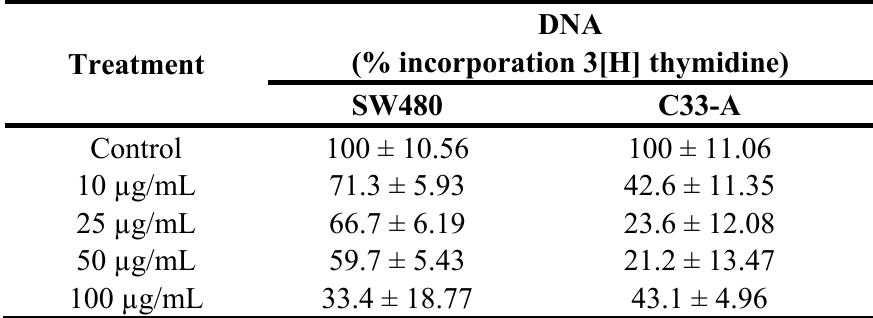
Table 2. Effect of tepary bean lectin on DNA synthesis in human malignant cells.